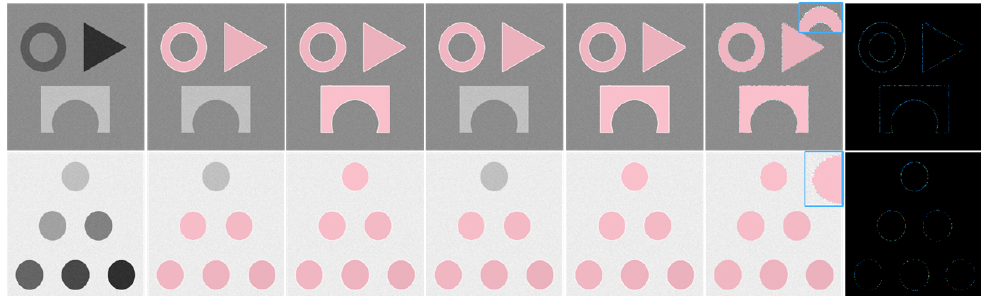
Figure 2. The comparison results on synthetic images. The first column is the images to be segmented, the middle five columns are the segmentation result of the five methods (CV [8], RSF [11], FEBAC [15], RLSF [31], and ours), and the last column is the uncertainty